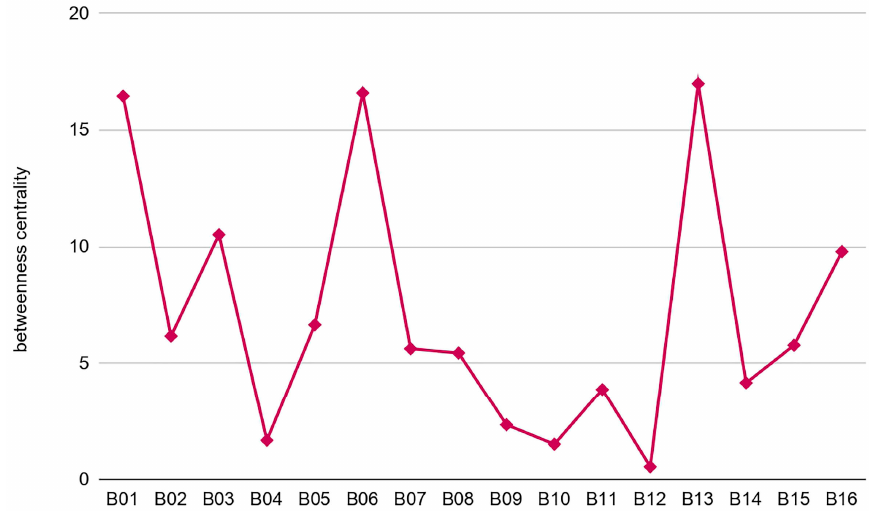
Figure 10. Betweenness Centrality Analysis of Barriers.